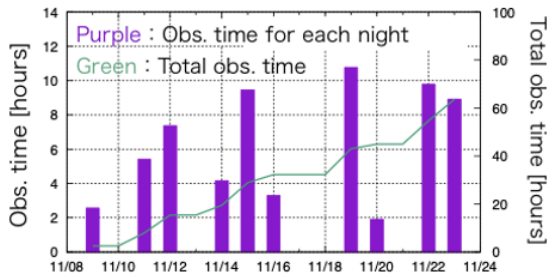
Figure 6. Purple is the observation time of each night and green is the total observation time.